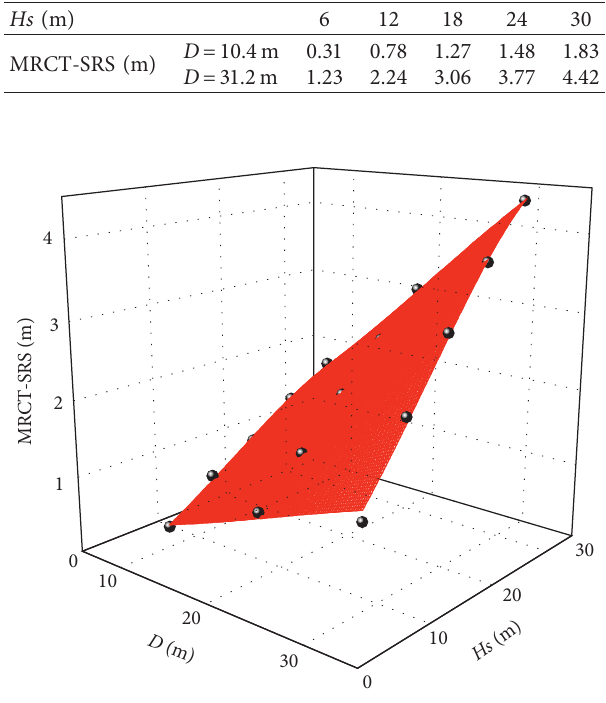
Figure 8: 3D MRCT-SRS ∼ Hs ∼ D diagram for metro tunnel.